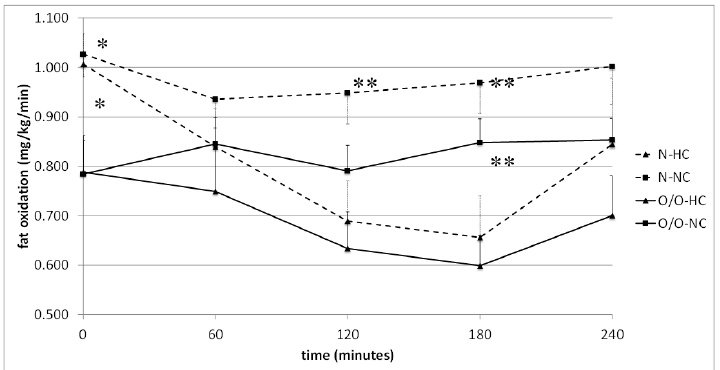
Figure 6. Fat oxidation (mg/kg/min) in people with normal body weight (N, the broken line) and overweight/obese people (O/O, the solid line) in fasting state (time 0 min) and after consumption (time 60–240 min) of a high-carbohydrate meal (HC) and a normo-carbohydrate meal (NC). The results are presented as mean values ± SE. The comparison between study groups N and O/O * p < 0.05; the comparison between meals HC and NC ** p < 0.05.